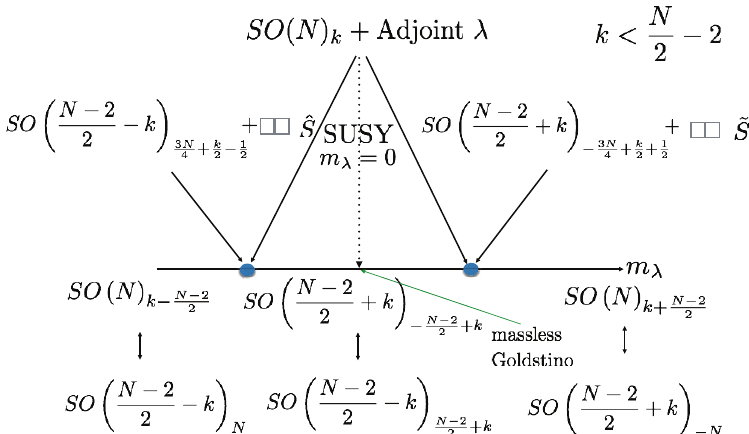
gauge theory with an adjoint fermion k